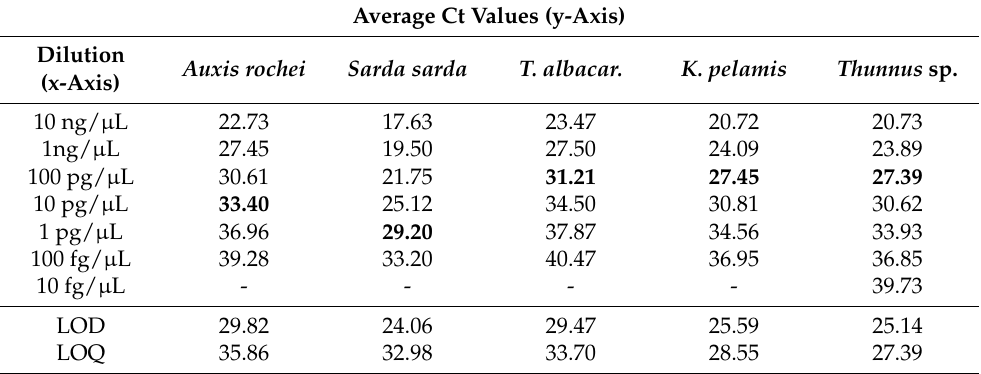
Table 2. Limit of detection for selected species.